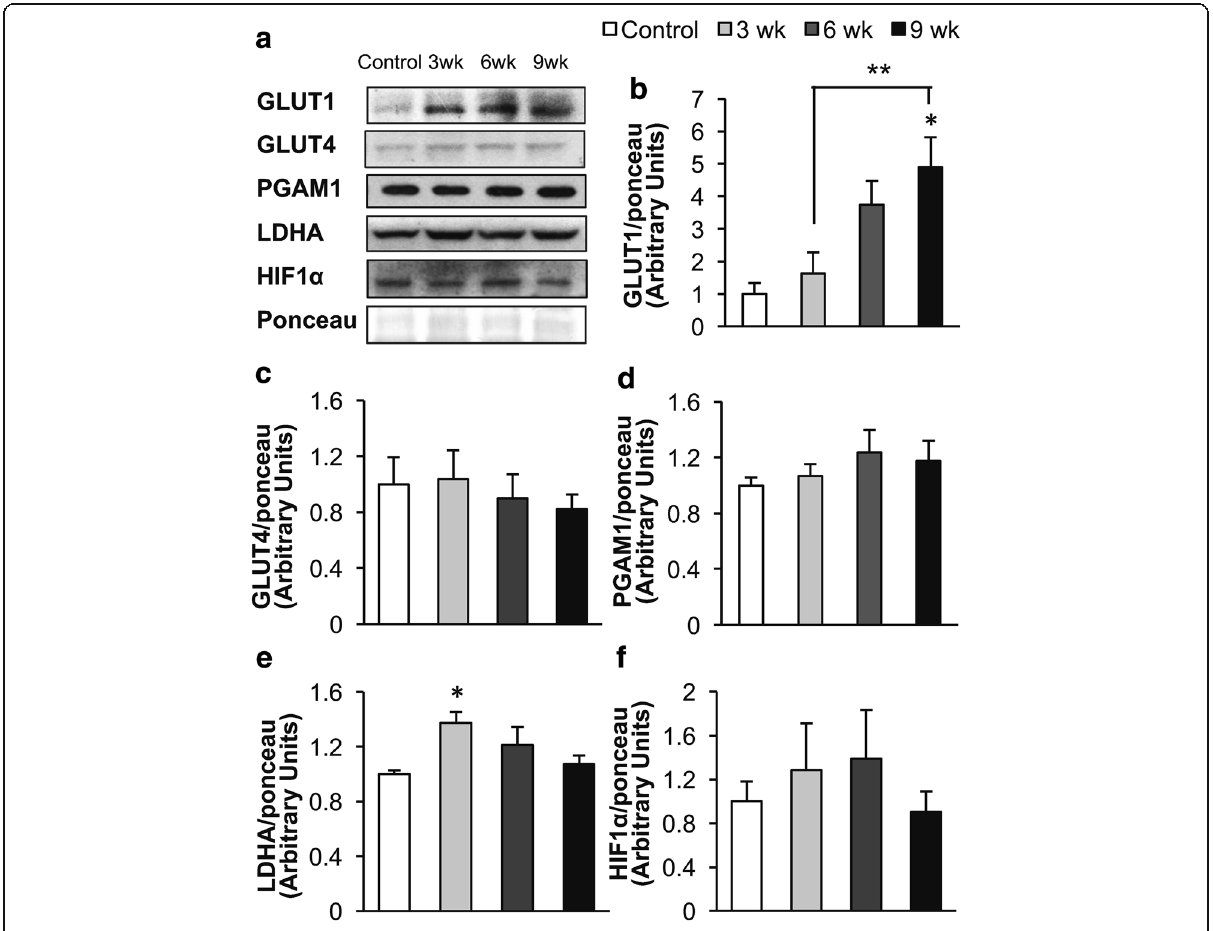
Fig. 3 Effect of a high salt diet (HSD) on Dahl salt-sensitive rat heart glucose metabolic enzymes. a Representative western blots. b GLUT1, ( c ) GLUT4, ( d ) PGAM1, ( e ) LDHA expression, and ( f ) HIF1 α protein expression was measured in hearts from Dahl salt-sensitive rats fed either a low salt diet, 0.3% NaCl (Control) or a HSD, 8% NaCl, for 3, 6, or 9 weeks. n = 4 – 9 * p < 0.05 compared to Control. ** p < 0.05 between compared groups. Values shown as mean ±